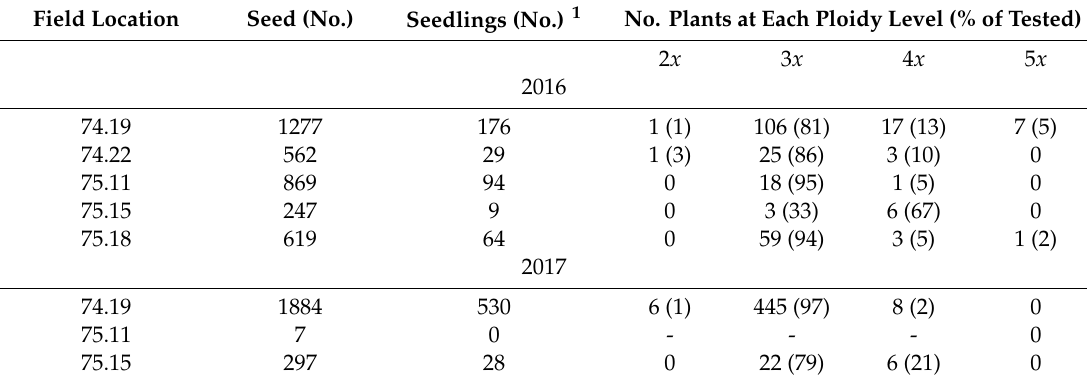
Table 6. Ploidy analysis using flow cytometry of seedlings resulting from open-pollination of field grown Acer tatricum ssp. ginnala (Amur maple) tetraploids. Seed were collected from 2016 and 2017 flowering seasons, respectively, and evaluated the following